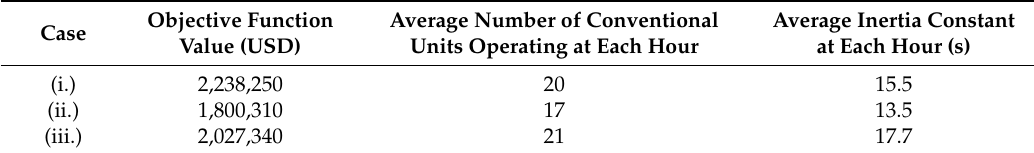
Table 2. Summary of unit commitment results.